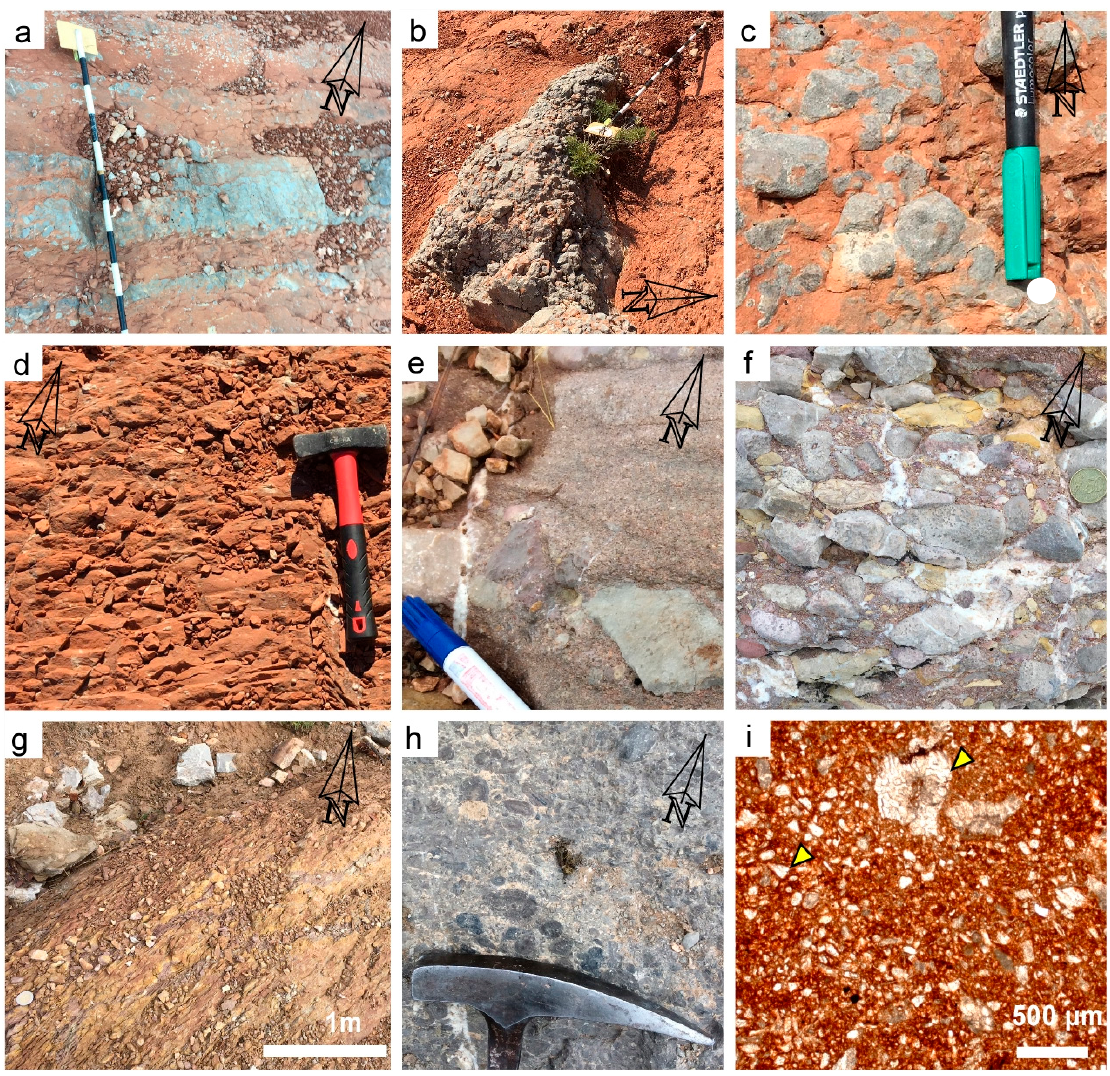
Figure 5. Field and photomicrographs of Paleocene Garumnian facies. ( a ) Red mudstones alternating with lacustrine limestones. ( b , c ) nodular lacustrine limestones. ( d ) Red mudstones. ( e ) Coarse sandstones with pebbles at the base. ( f ) Conglomerates. ( g ) Versicolored clays. ( h ) Oncolitic packstone. ( i ) Plane polarized photomicrograph of Microcodium packstones. The yellow arrows point to massive Microcodium and reworked fragments.